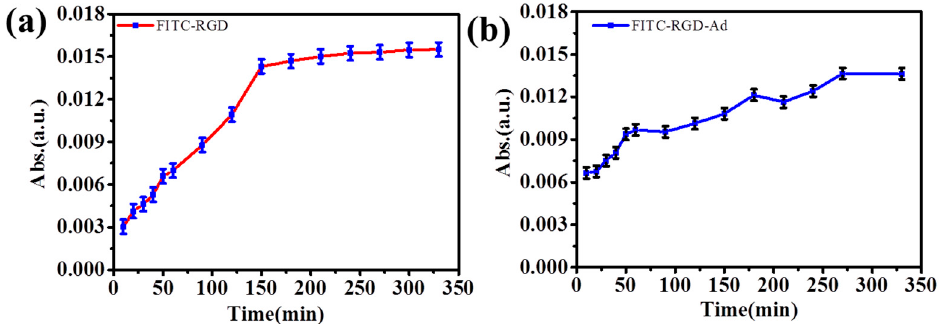
Figure 3. The release profiles of ( a ) FITC-RGD and ( b ) FITC-RGD-Ad from (PAH/SiO 2 ) 1 /(PAH/HA-CD) 3 /(PAH/SiO 2 ) 1 /(PAH/HA-CD) 3 multilayer films.